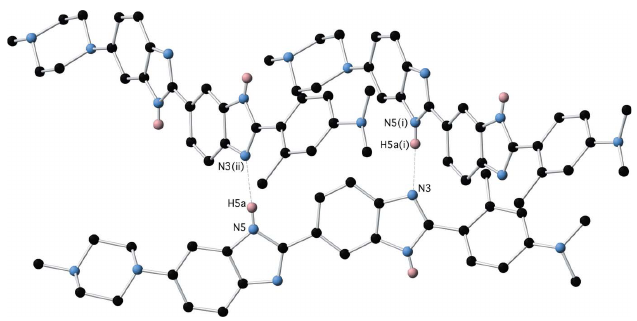
Figure 6 The cross-linking N—H (cid:2)(cid:2)(cid:2) N hydrogen bonds between benzimidazole moieties molecules of (1).